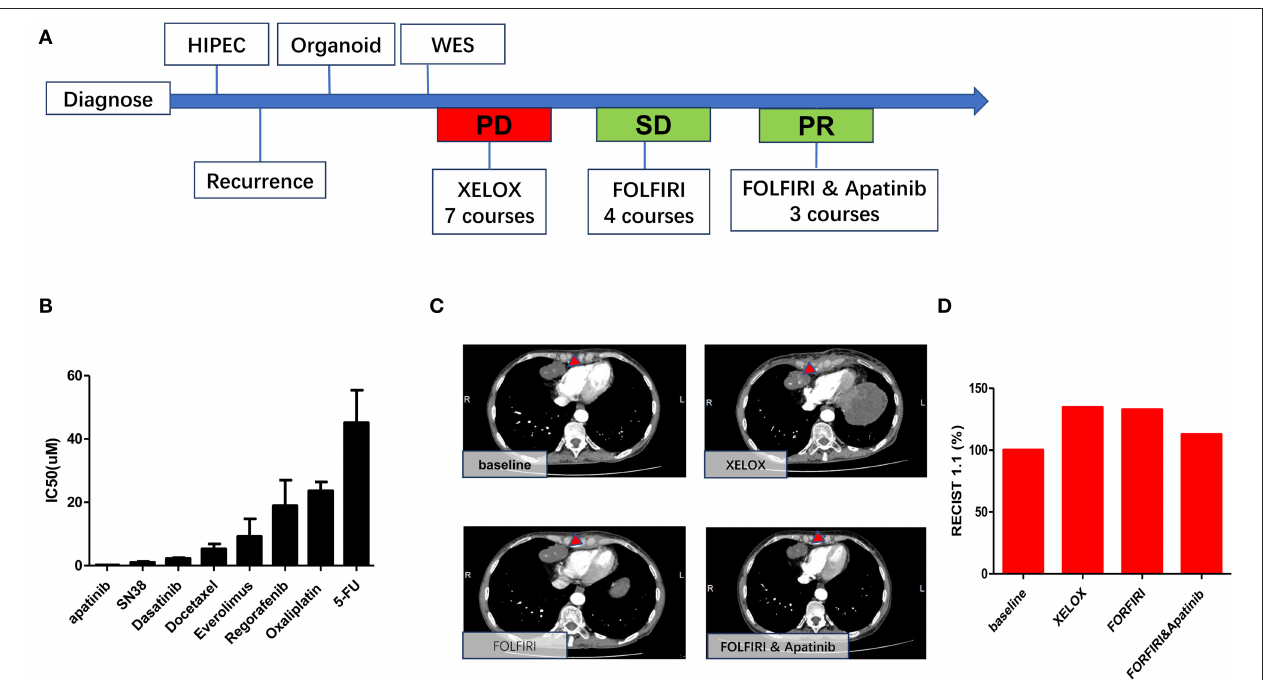
FIGURE 6 | Consistency between organoid and patient responses to different drugs. (A) Timetable of disease progression. (B) Drug sensitivity data indicating low sensitivities to 5-fu and oxaliplatin and high sensitivities to apatinib and SN38. (C) Representative CT images of heart diaphragm angle lymph node after treatment. (D) Sum of the length and width of heart diaphragm angle lymph node after treatment with XELOX, FORFIRI, and FORFIRI and apatinib, red bars indicate volume of the target metastasis [according to RECIST